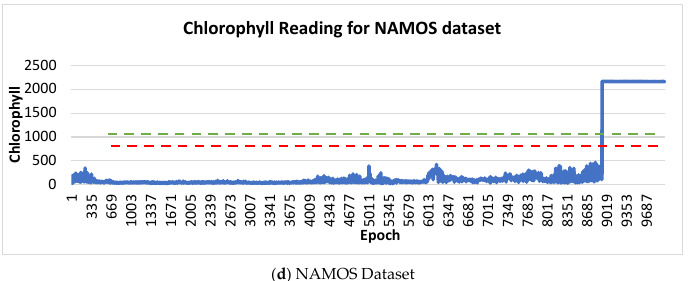
Figure 5. Histogram plots for ( a ) IBRL, ( b ) LUCE, ( c ) PDG and ( d ) NAMOS Dataset .